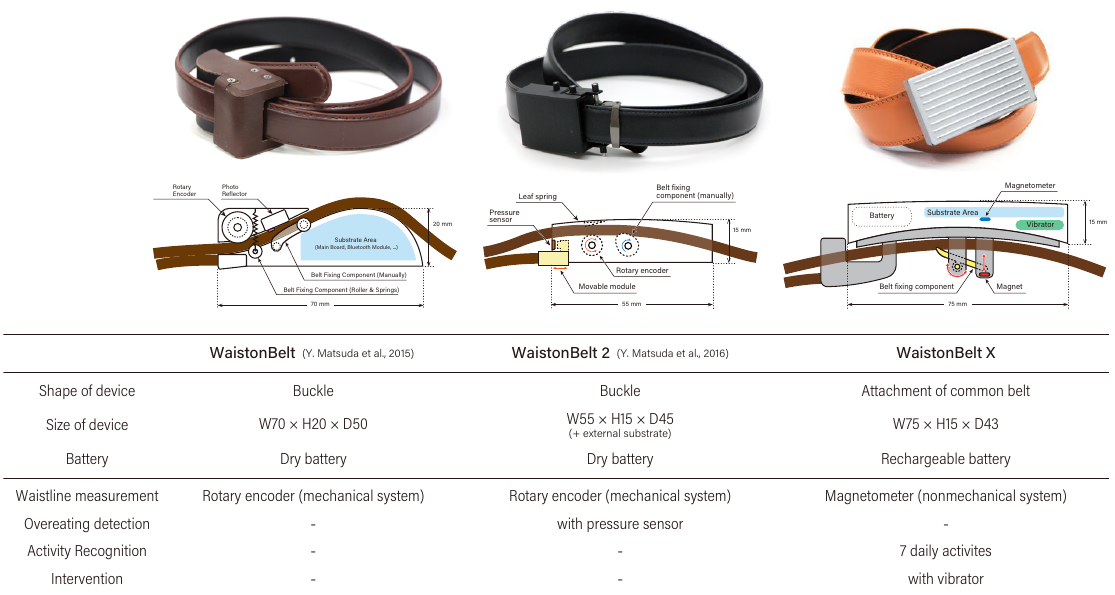
Figure 18. Previous work related to